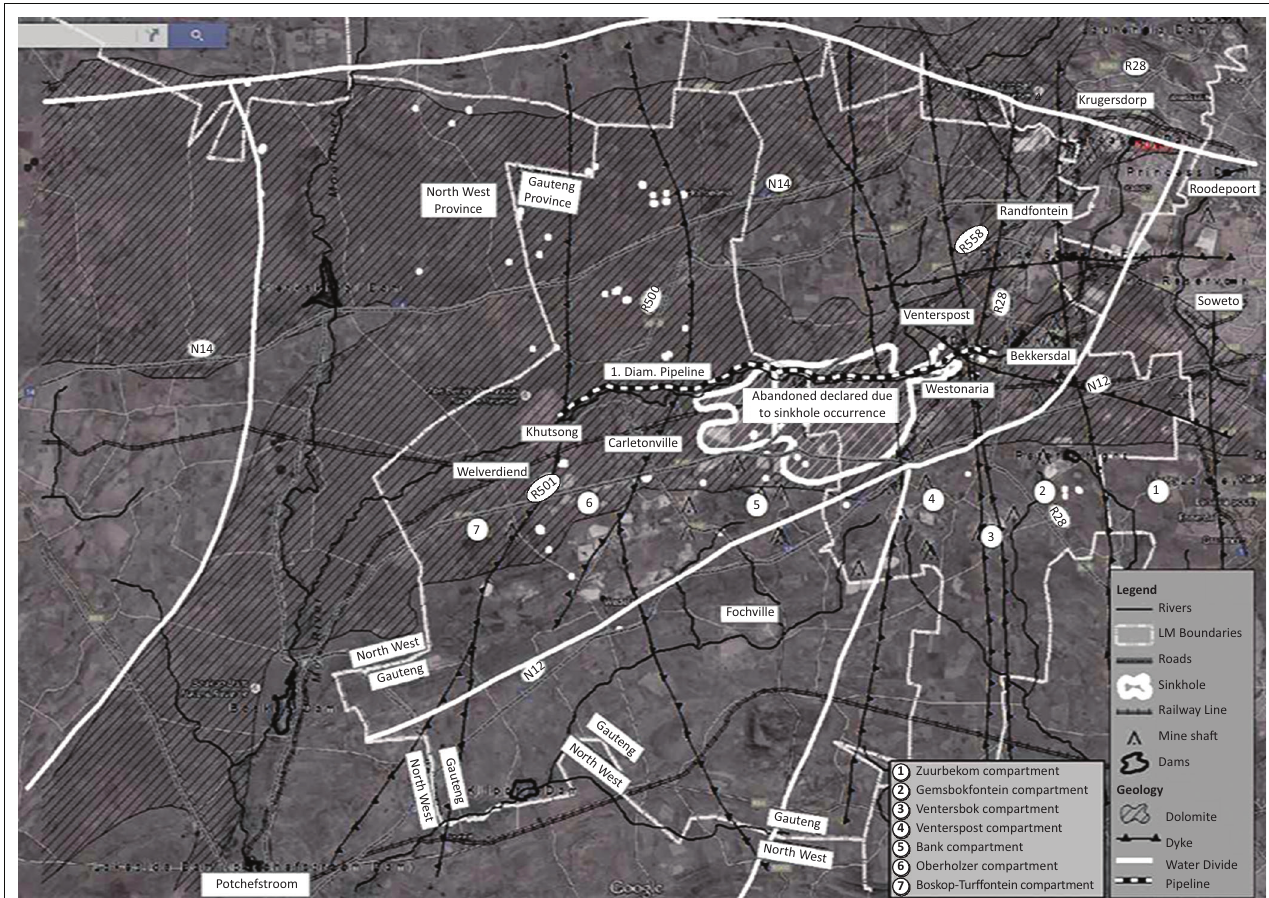
FIGURE 1: Locality map of the Westonaria and Merafong City Local Municipality